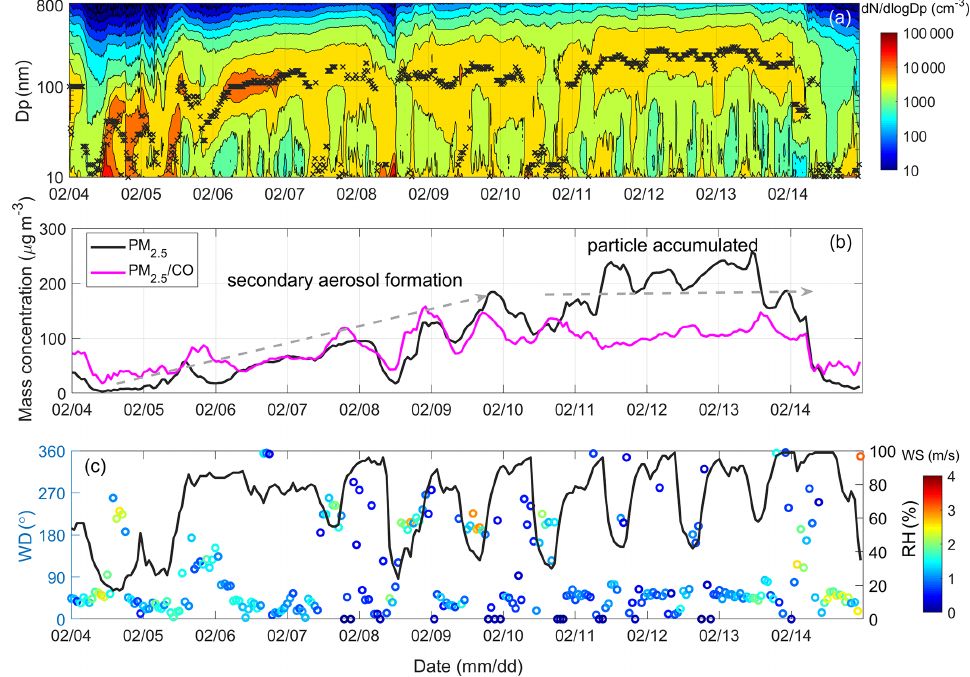
Figure 10. Time evolution of PNSD and the dominant geometric mean diameters (black cross) derived by the log-modal fitting (a) and hourly mean PM 2 . 5 (black line), normalized PM 2 . 5 by CO (pink line) in (b) and the meteorological factors: wind direction (WD), wind speed (WS), and relative humidity (RH, black line) in (c) on 4–14 February.